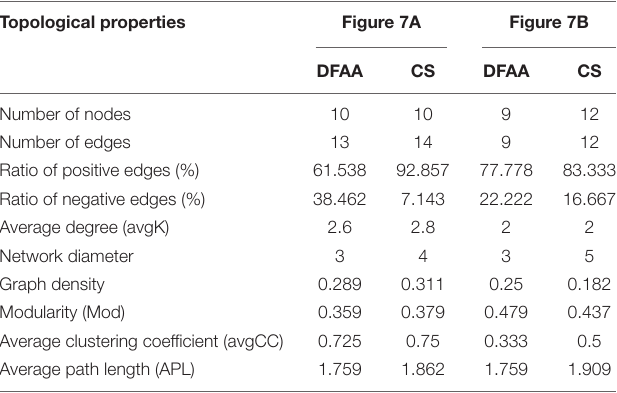
TABLE 4 | Topological properties of co-occurrence networks. Figure 7A Figure